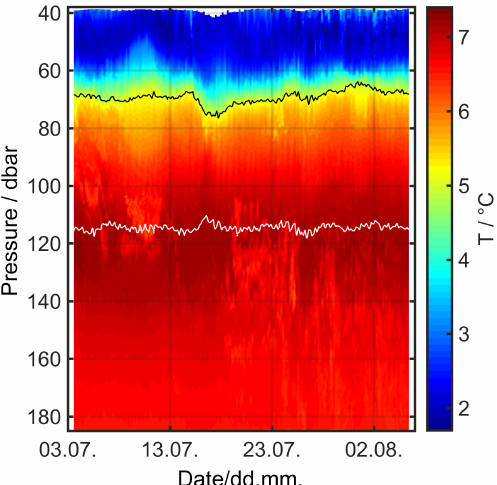
Figure 7. Plot of temperature (colour-coded) over deployment date and pressure for the second deployment, 3 July–5 August 2010. The lines at around 70dbar (black) and around 115dbar (white) denote the isopycnals of 1007.6 and 1009.5kgm − 3 respectively, indicating the division between oxic and hypoxic (upper line) and between hypoxic and anoxic waters (lower